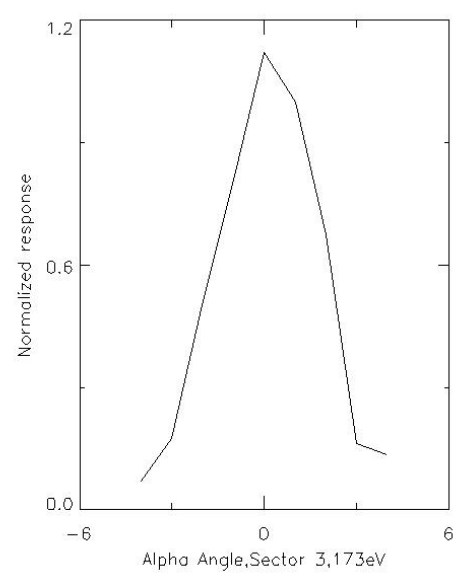
Fig. 7. Intrinsic azimuthal angle resolution of Sector 3 at energy level of 173eV.